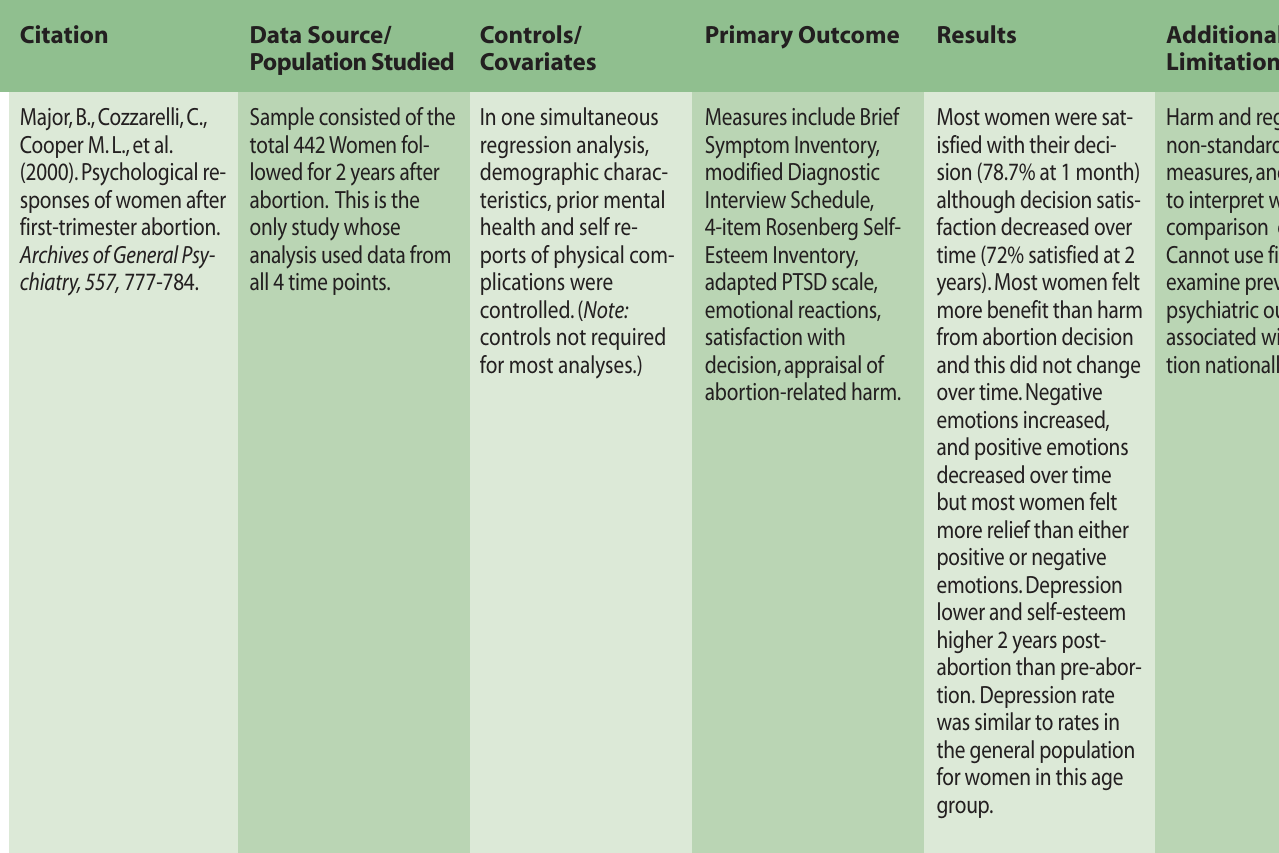
Table 5: U.S.Samples of Abortion Group(s) Only/No Comparison Prospective Analyses Using Major et al.Multiple Site Sample General Description: Women followed for 2 years after an elective first-trimester abortion for an unintended pregnancy,recruited from 3 sites in Buf- falo, NY in 1993.Four assessments:1 hour before abortion,and 1 hour,1 month,and 2 years after the abortion;85% (N = 882) of eligible women agreed to participate,completing preabortion and 1 hour postabortion questionnaires;follow-up questionnaires were completed 1 month ( N = 615) and 2 years ( N = 442) post abortion.The age range was 14-60;65% were White/other. Limitations Common to All Studies Based on this Data Set: Common to All Studies Based on this Data Set:No comparison group (not a lim- itation for majority of studies which examined risk factors,mediators,and moderators of post-abortion psychological distress).Sample may not be repre- sentative of women who obtain abortions in the U.S.,although only sociodemographic difference from national comparison sample was underrepresentation of Hispanic women.High attrition:30% at 1 month and 50% at 2-year follow-up,but women retained did not differ from women lost to follow-up at either time point on demographic or psychological measures.Does not include measures such as domestic violence and sexual abuse that may be related to post-abortion